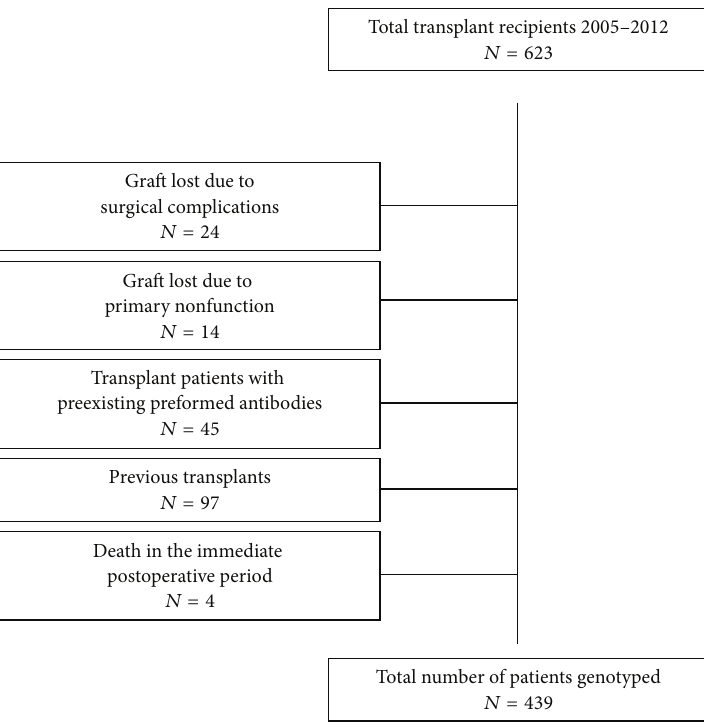
Figure 1: Flow-chart: kidney